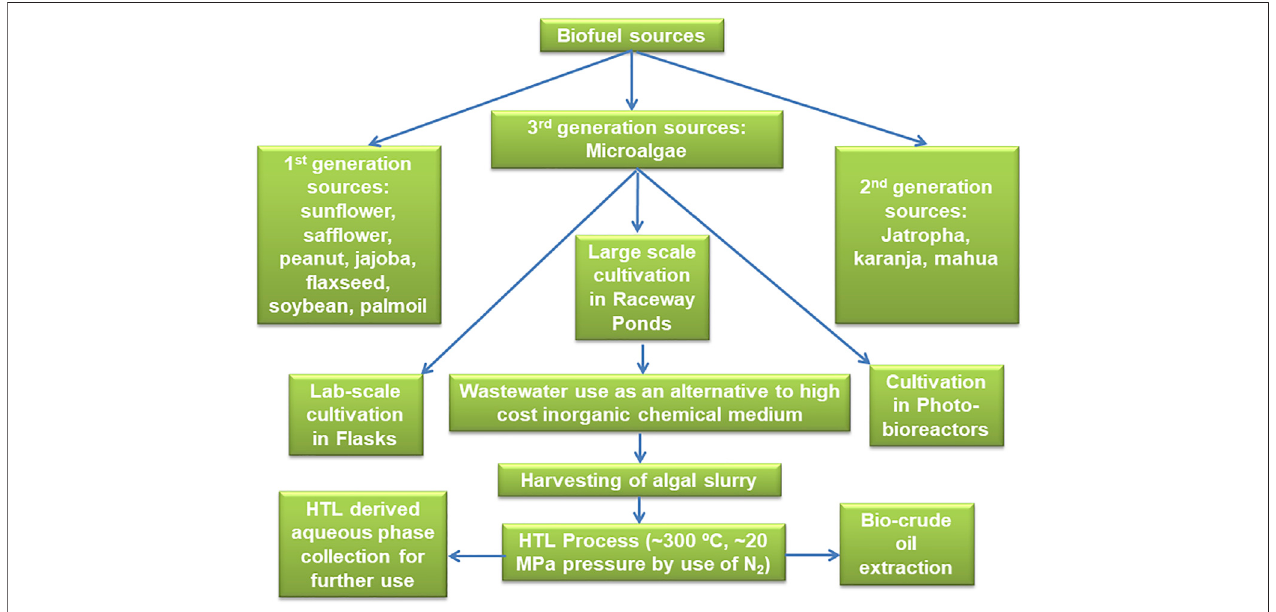
FIGURE1| Schematic illustration ofmicroalgalbiodieselproduction techniques focuses onlarge-scalecultivation strategies inracewayponds and directbiomass processing to oil using hydrothermal liquefaction.